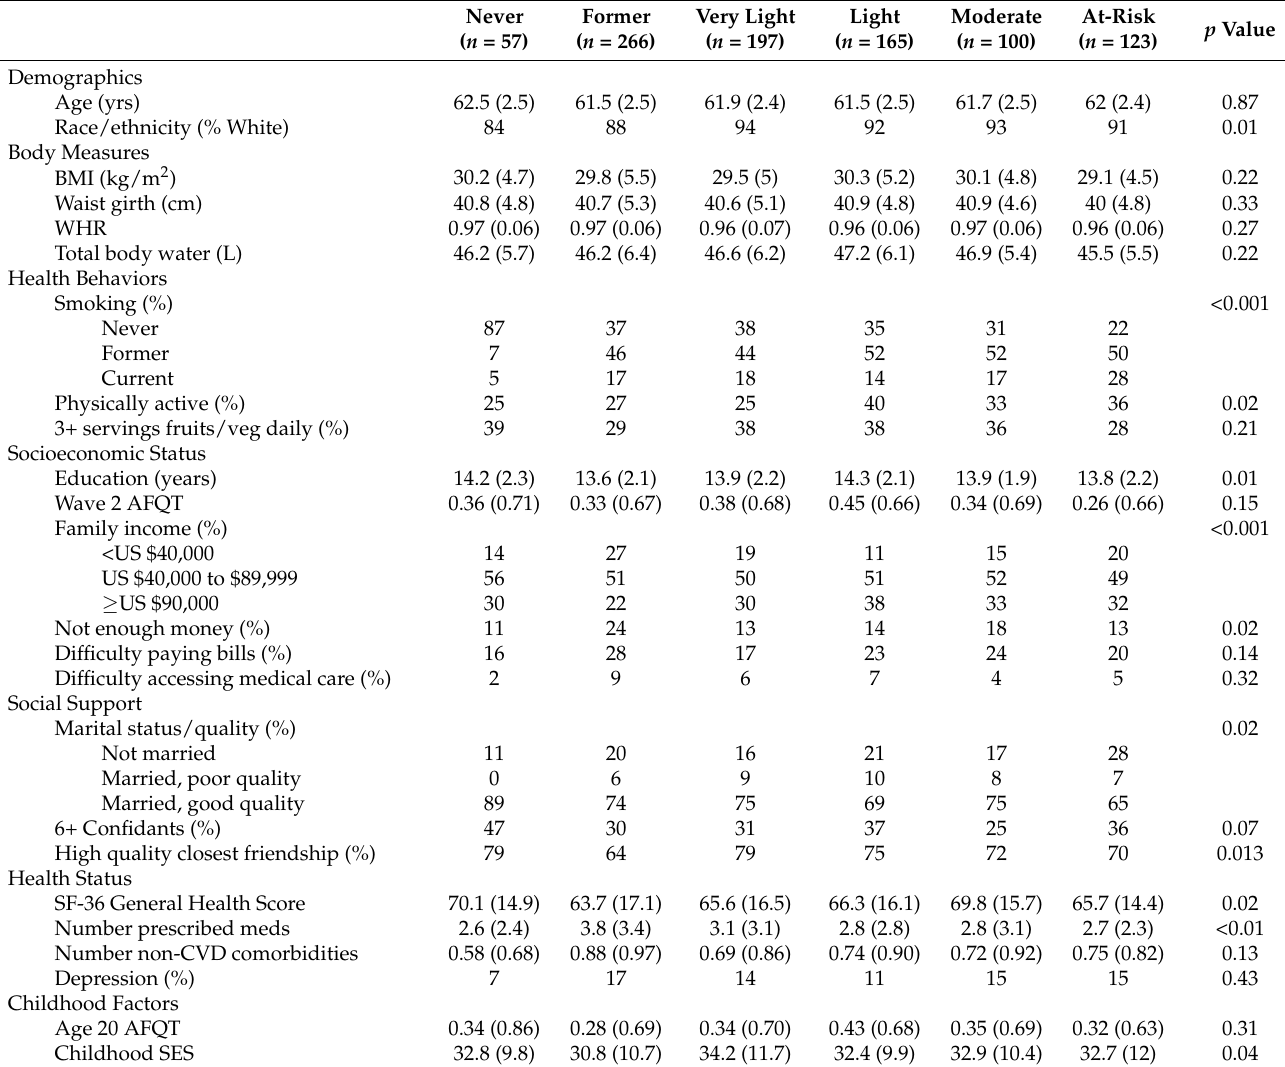
Table 2. Participant characteristics by drinking